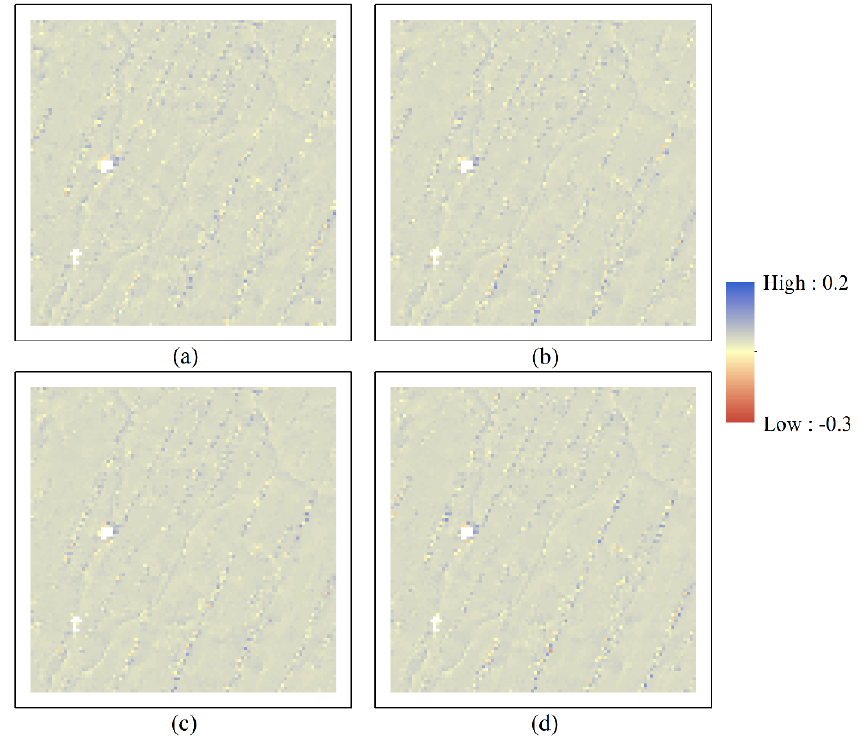
Figure 15. Spatial distribution of the simulated C values of the subregion for the threshold value of: